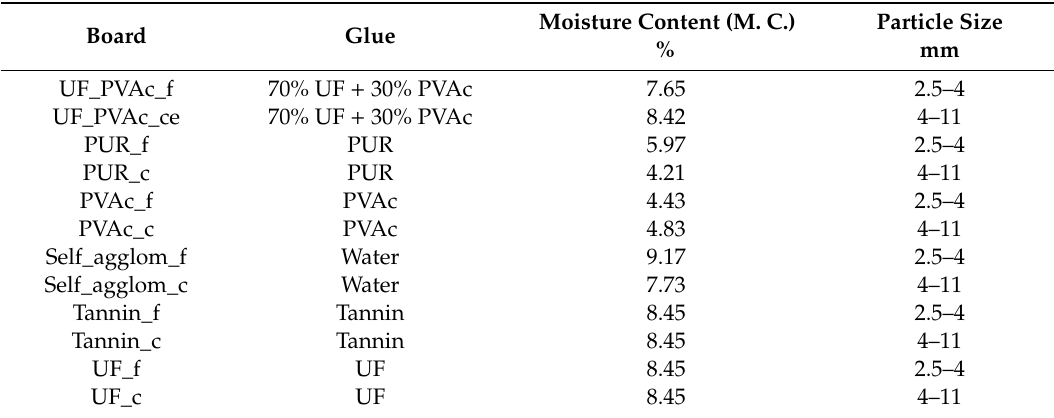
Table 1. Experiment design with factor larch-bark particle size (two replications for each decorative board). Note: PUR, polyurethane; PVAc, polyvinyl acetate; UF,